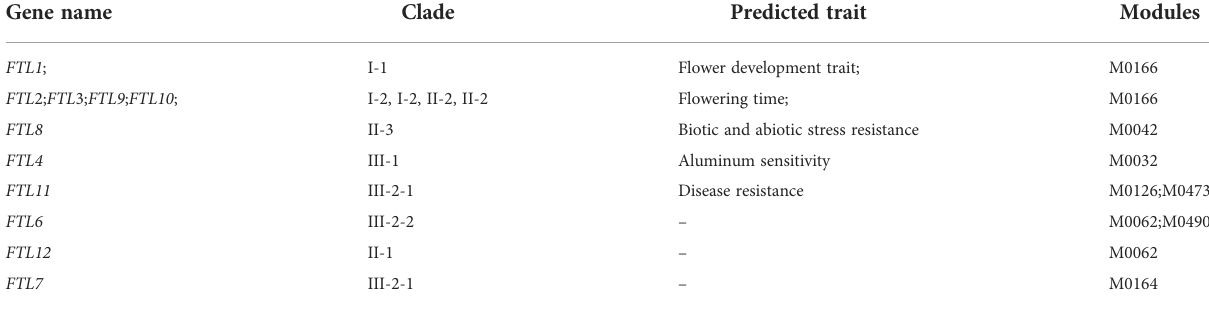
TABLE 6 Rice FT co-expression module information.